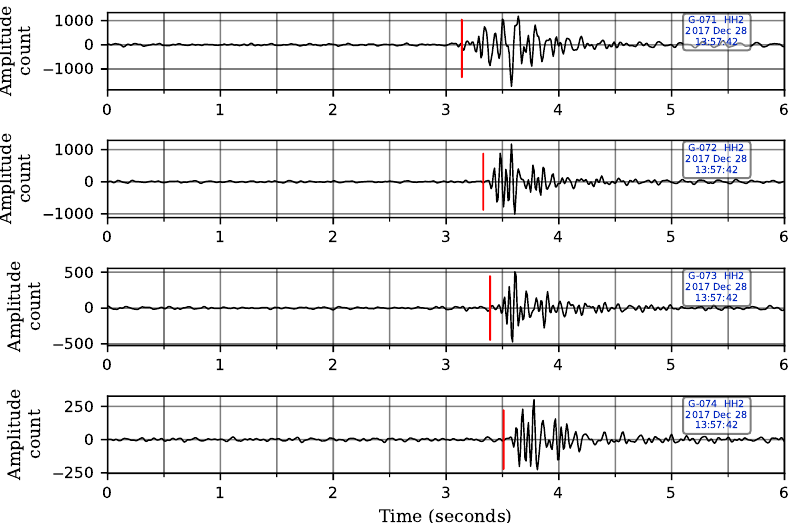
Figure 3. The moveout pattern of noise coming from the surface observed across the four geophone levels. The red vertical lines denote the first-arrival times of the seismic wave at each sensor. The wave arrives first at the shallowest sensor and propagates downwards. A bandpass filter between 5–25 Hz has been applied to the records. Note that only one of the horizontal components is shown here for illustration. The waveforms are displayed in sequence with the waveform from the shallowest sensor at the top and the one from the deepest sensor at the